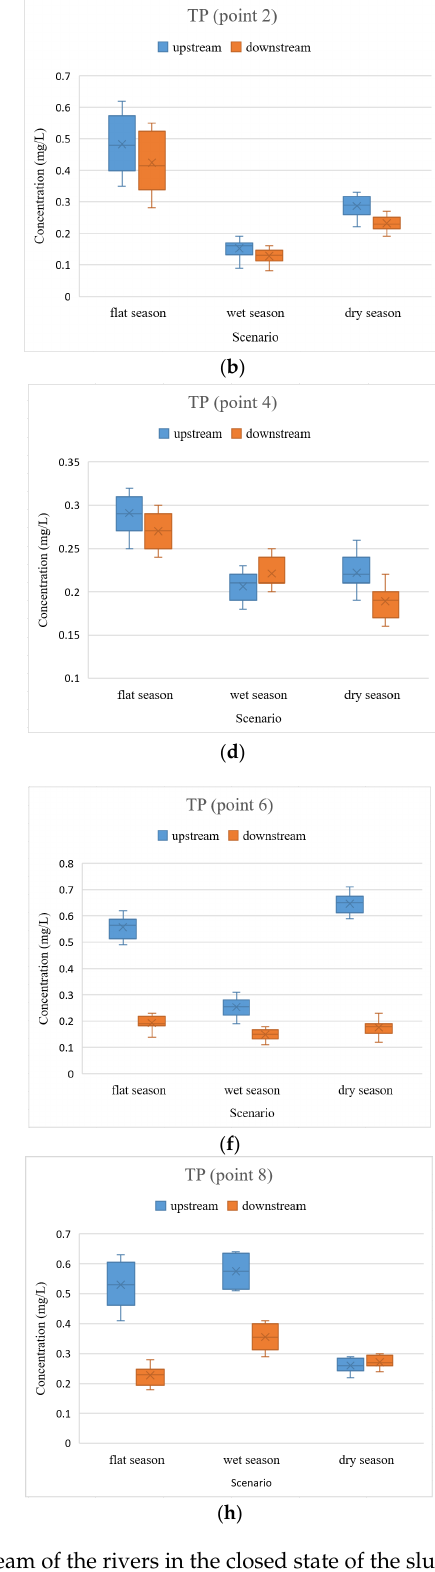
Figure 3. Comparison of TP upstream and downstream of the rivers in the closed state of the sluices. ( a ) TP concentrations at point 1; ( b ) TP concentrations at point 2; ( c ) TP concentrations at point 3; ( d ) TP concentrations at point 4; ( e ) TP concentrations at point 5; ( f ) TP concentrations at point 6; ( g ) TP concentrations at point 7; ( h ) TP concentrations at point 8. The concentrations of TP and TN were relatively low during the wet and dry seasons compared to those in the flat-water season due to the fact that the wet and dry seasons are the summer and autumn seasons in Wuxi, with more rainfall. On the one hand, the high precipitation leads to the high storage capacity of rivers and the constant turnover of the water body. These are conducive to pollutant concentration reduction. On the other hand, for flood control purposes, the sluices are opened to release flood water when there is excessive rainfall. Furthermore, the river flows faster, and some pollutants from the river will flow into larger water bodies such as the Beijing–Hangzhou Grand Canal, which con- tributes to reducing pollutant concentrations. In addition, there are some cases of excessive pollutant concentrations during the wet and dry seasons; for example, the TN concentrations upstream of the rivers in the wet seasons (Figure 2c,e,h) and the TP concentrations upstream of the rivers during the wet and dry seasons (Figure 3f,h), respectively. This is due to the fact that summer and autumn are not only the peak season of precipitation in Wuxi but also the peak period for indus- trial production and domestic sewage discharge. The combination of effluent discharge, sluice closure, and high temperatures during periods brings about high concentrations of these pollutants, especially during the time when it does not rain. This result is similar to previous studies [33].